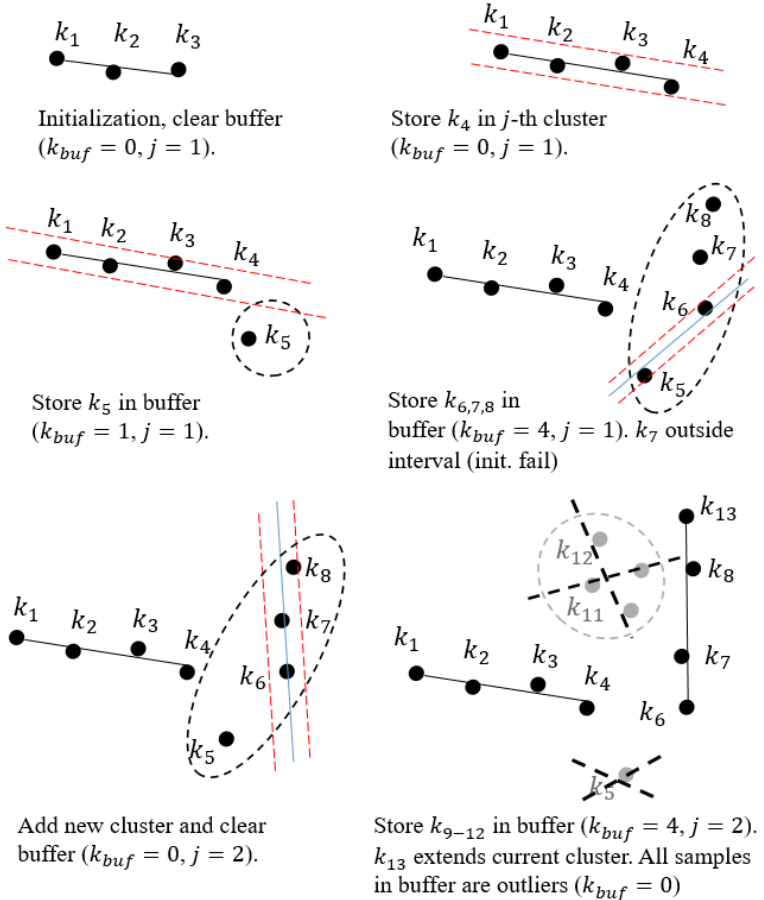
Figure 11. Illustration of the line segment clustering operation. The first k min = 3 samples initialize the first cluster. The next sample extends the first cluster if it is sufficiently close to the straight line. Samples ( k 5 : k 8 ) fall outside the acceptance interval and therefore are buffered until k min collinear and consistent samples form a new cluster. Sample k 5 is characterized as an outlier when a new cluster is found. Next, samples ( k 9 : k 12 ) are buffered due to the failed extension of the active cluster and by the confirmed active cluster extension with sample k 13